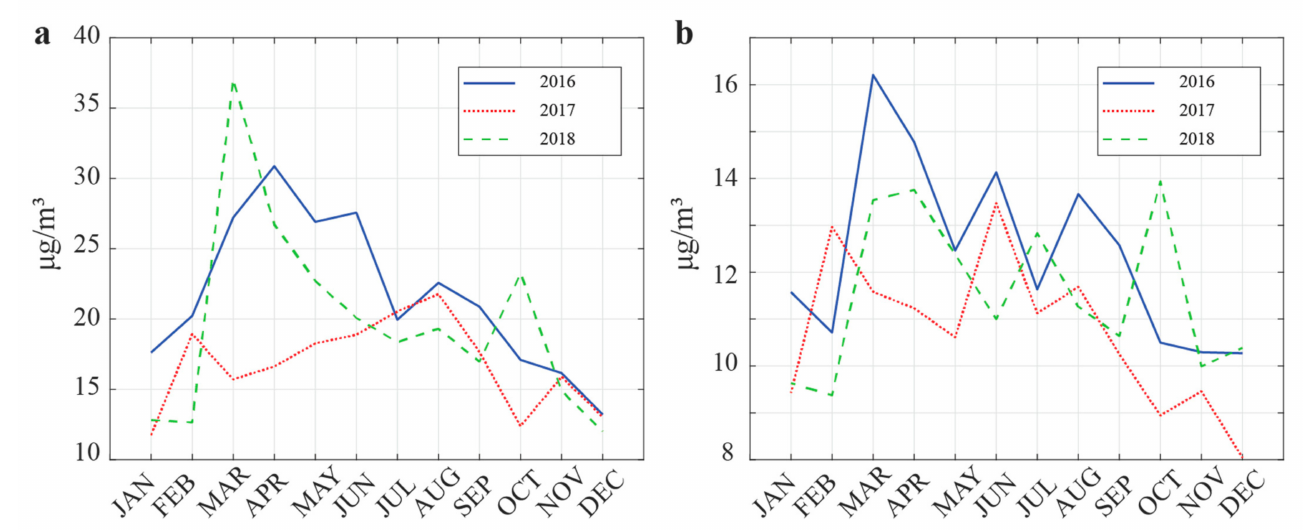
Figure 2. Monthly averaged concentrations for PM 10 and PM 2.5 (( a , b ) respectively) and for the three-year time period (2016–2018) at AGP target